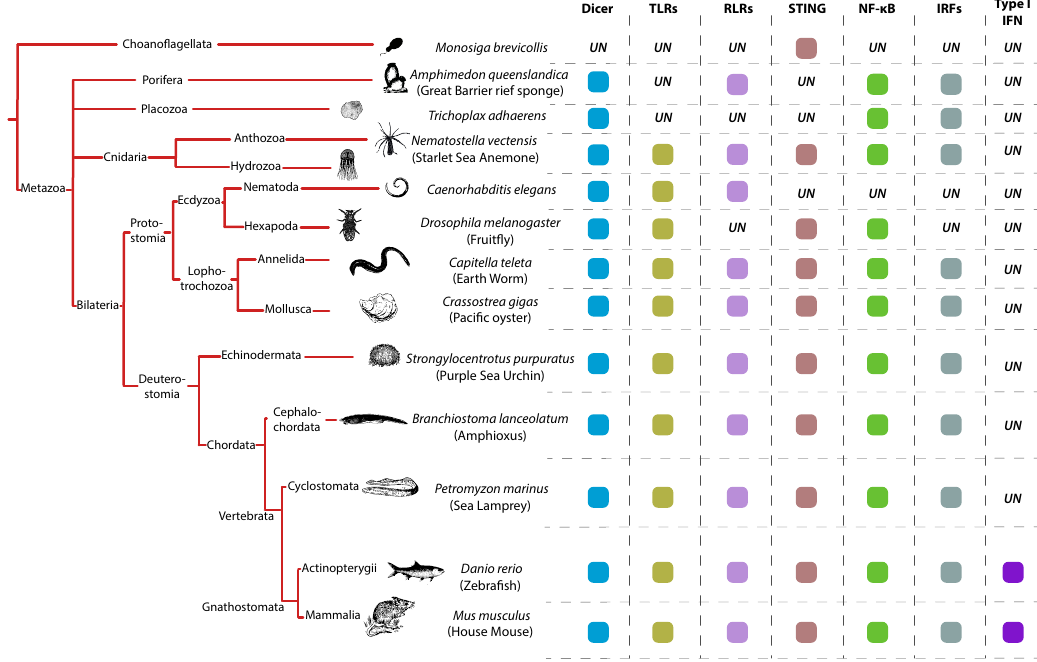
Figure 2. Conservation of key antiviral genes across the animal kingdom. Displayed is a simplified taxonomic branching order diagram of Metazoa with one outgroup (Choanoflagellata), adapted from [6]. Depicted is the presence of selected innate immune factors in representative species from Metazoa and Bilateria starting from Porifera up until Mammalia. The presence of DICER—a central component of the RNAi pathway, of the pattern recognition receptors TLRs and RLRs, of the signaling molecule stimulator of IFN genes (STING) and the e ff ectors NF-kB, IRFs and IFN—is indicated by colored squares. Absence is indicated by UN (unidentified). References used to construct this figure are listed